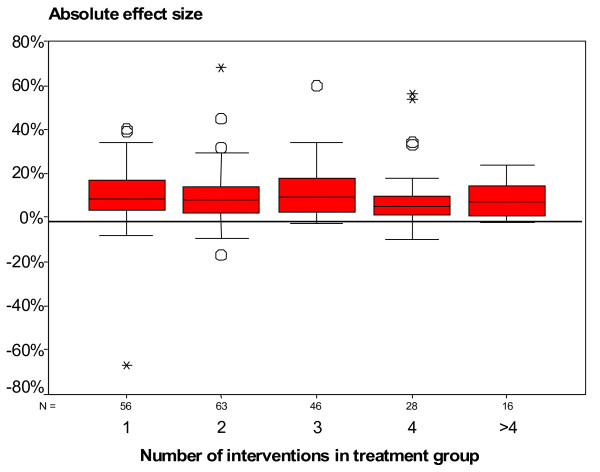
Effect sizes of multifaceted interventions by number of interventions.